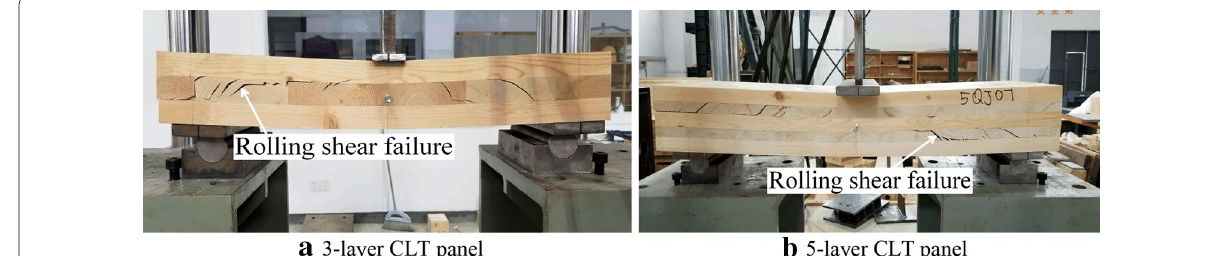
Fig. 10 Failure modes of CLT shear specimens